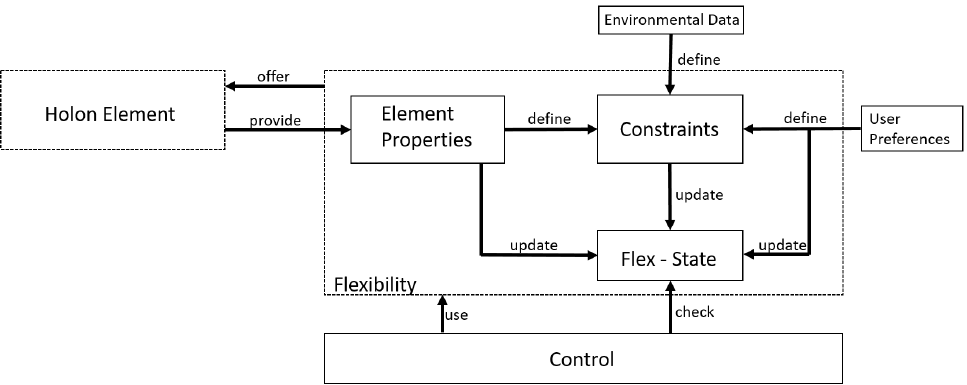
Figure 3. Abstract representation of the flexibility model and the corresponding interaction with a control